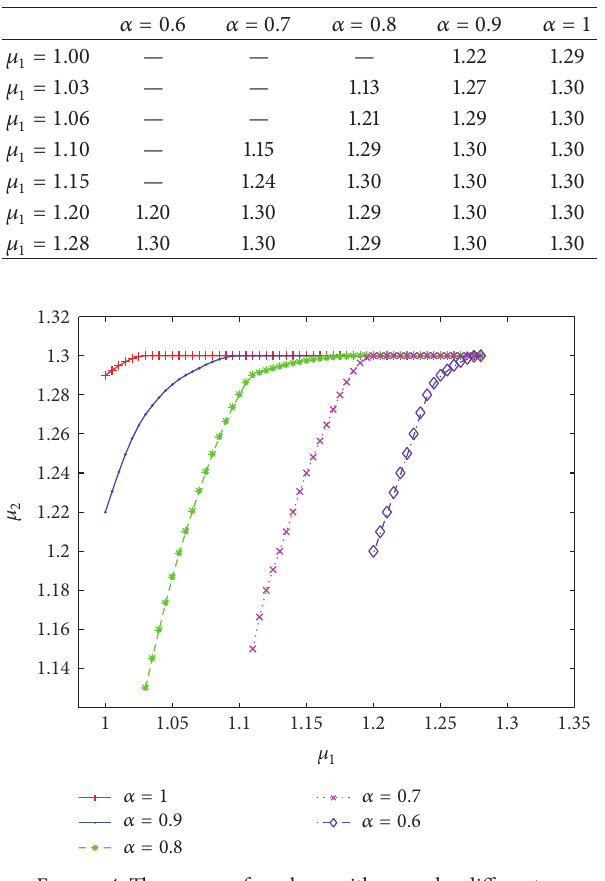
Figure 4: The curves of 𝜇 2 along with 𝜇 1 under different 𝛼 .